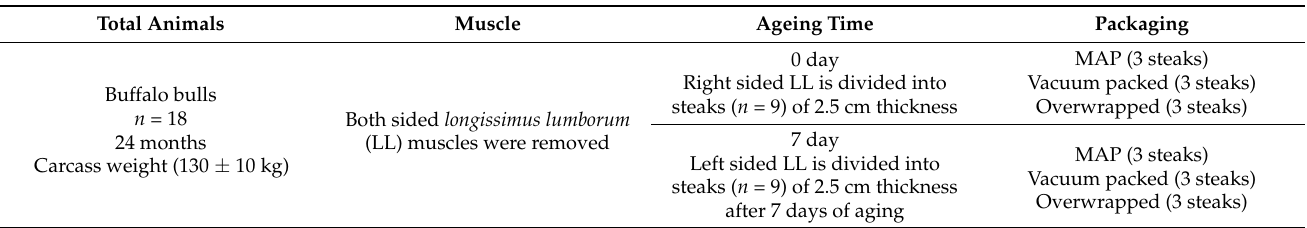
Table 1. A brief layout of experimental design. Muscle Ageing Time